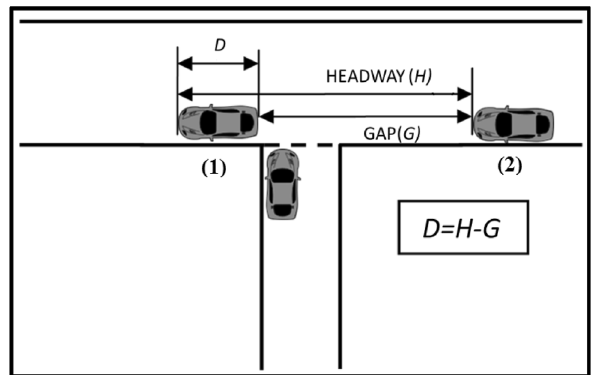
Fig. 5 Definition of clearing time